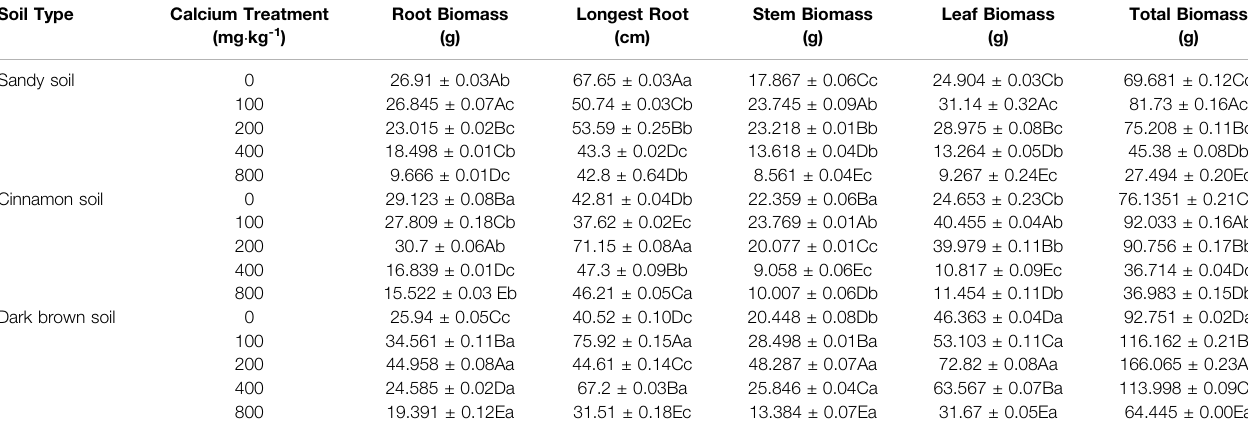
TABLE 1 | Effects of exogenous calcium on the biomass of Mongolian pine seedlings in different soil types. Soil Type Calcium Treatment (mg · kg -1